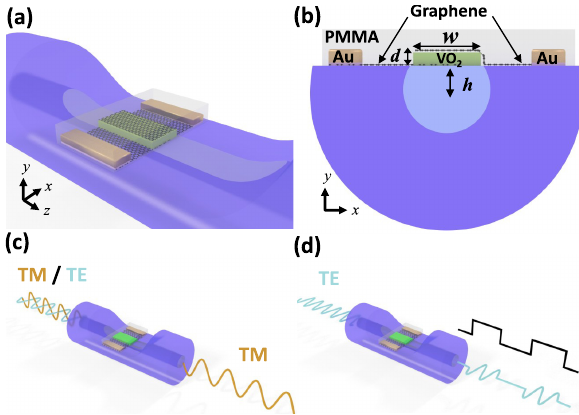
Figure 1: (a) The perspective view of the proposed in-line fiber layer on the side-polished modulator formed by overlaying a VO 2 fiber. (b) The cross-section details. Bi-function operation as (c) TM-pass polarizer and (d) TE